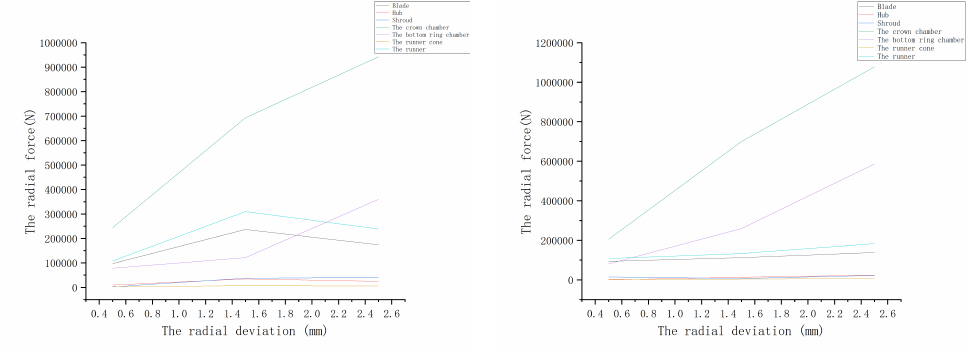
Figure 6. The differences in the radial forces between the radial deviation model with speed or without.